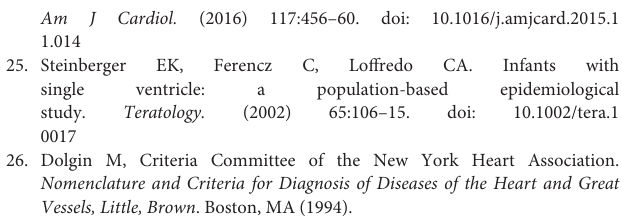
26. Dolgin M, Criteria Committee of the New York Heart Association. Nomenclature and Criteria for Diagnosis of Diseases of the Heart and Great Vessels, Little, Brown . Boston, MA